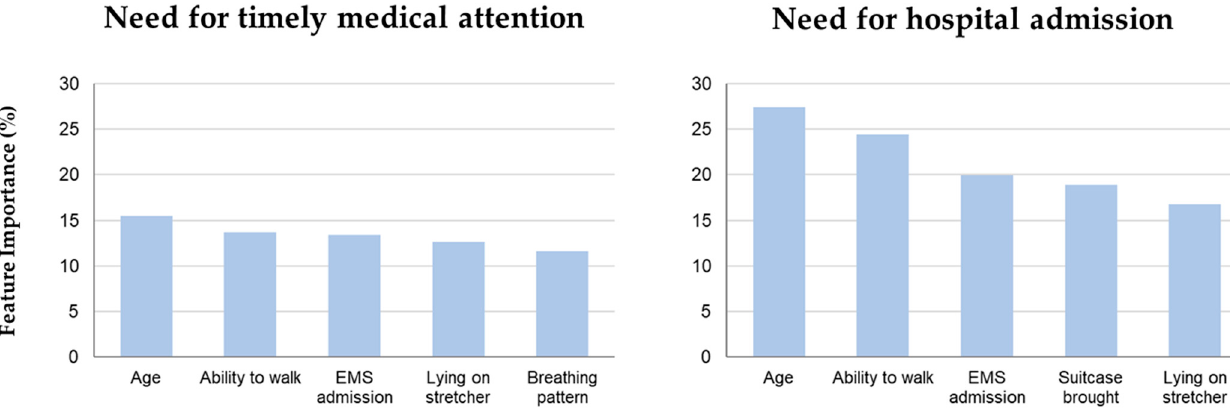
Figure 3. Frequencies of the need for timely medical attention and hospital admission depending on the ability to walk as well as the predictive value of the inability to walk at triage presentation. NPV, negative predictive value; PPV, positive predictive value; Sens., sensitivity; Spec., specificity. 4. Discussion In this prospective, observational study, we found that the first clinical impression of patients presenting to the triage desk in an emergency department could reliably predict the need for timely medical attention and the need for hospital admission, but not in- hospital mortality. Important features informing the prediction models were age, ability to walk, admission by emergency medical services, lying on a stretcher, breathing pattern, and bringing a suitcase. The inability to walk at triage presentation was highly predictive of both the need for timely medical attention and the need for hospital admission. Due to center-specific admission pathways for critically ill patients and those with time-critical conditions such as ST-elevation myocardial infarction and stroke, our population largely included non-critically ill patients. This is important to remember when interpreting the study results and comparing our results to those of other authors. We deliberately chose one final-year medical student to collect data on the first clinical impression. Thus, we avoided any inter-rater bias and made sure that the clinical experience of the researcher did not bias the recognition and interpretation of components